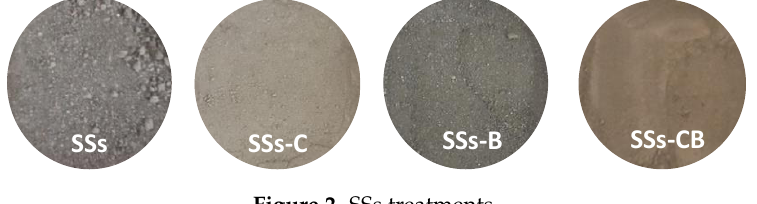
Figure 2. SSs Figure 2. SSs treatments.